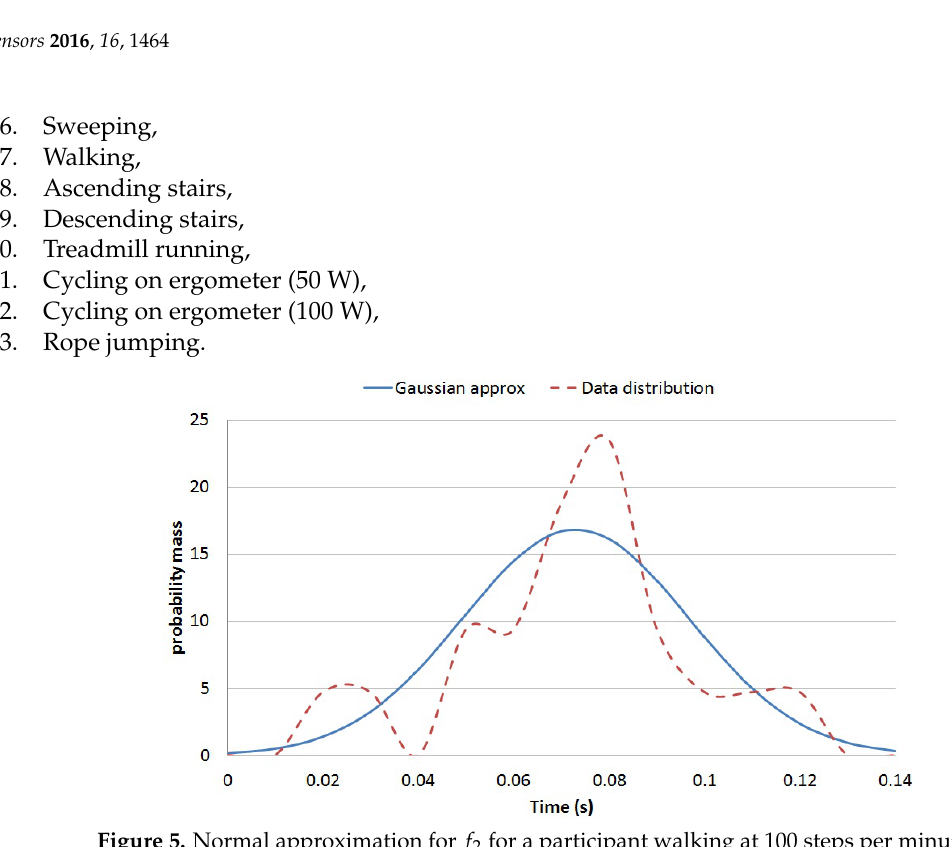
Figure 5. Normal approximation for f 2 for a participant walking at 100 steps per minute.